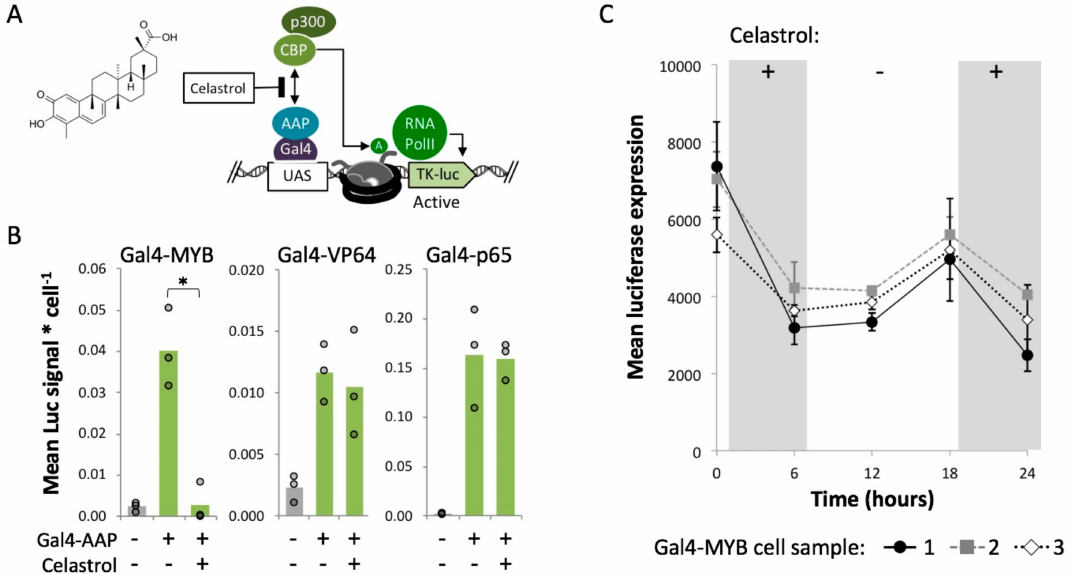
Figure 4. Celastrol disrupts Gal4-MYB-mediated activation of luciferase in closed chromatin. ( A ) The p300 / CBP complex acetylates histones via the catalytic HAT domain of p300 and / or CBP [70]. Celastrol inhibits the recruitment of p300 / CBP by MYB by binding a docking domain in CBP that facilities complex assembly [72,74]. ( B ) Three days after Gal4-EED-mediated repression of Tk-luciferase and transfection with Gal4-AAPs, cells were treated with 5 µ M celastrol for six hours and collected for luciferase assays. Mean luciferase (Luc) signal per cell is presented as described for Figure 2C. Asterisk (*) = p < 0.05. ( C ) Luc measurements were carried out in Gal4-MYB-expressing cells after removal ( − ) and re-addition ( + ) of celastrol. Each series (Gal4-MYB cell sample) represents an independent transfection. Point = mean of three luciferase assays, bars = standard